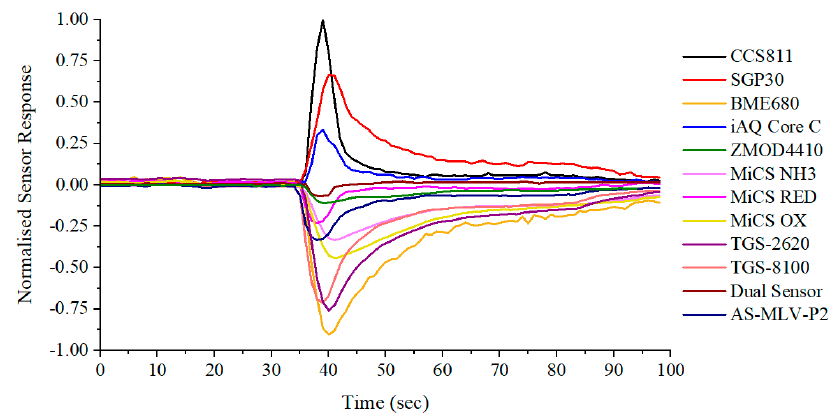
Figure 11. Breath sampling reproducibility using carbon dioxide and humidity sensor readings.